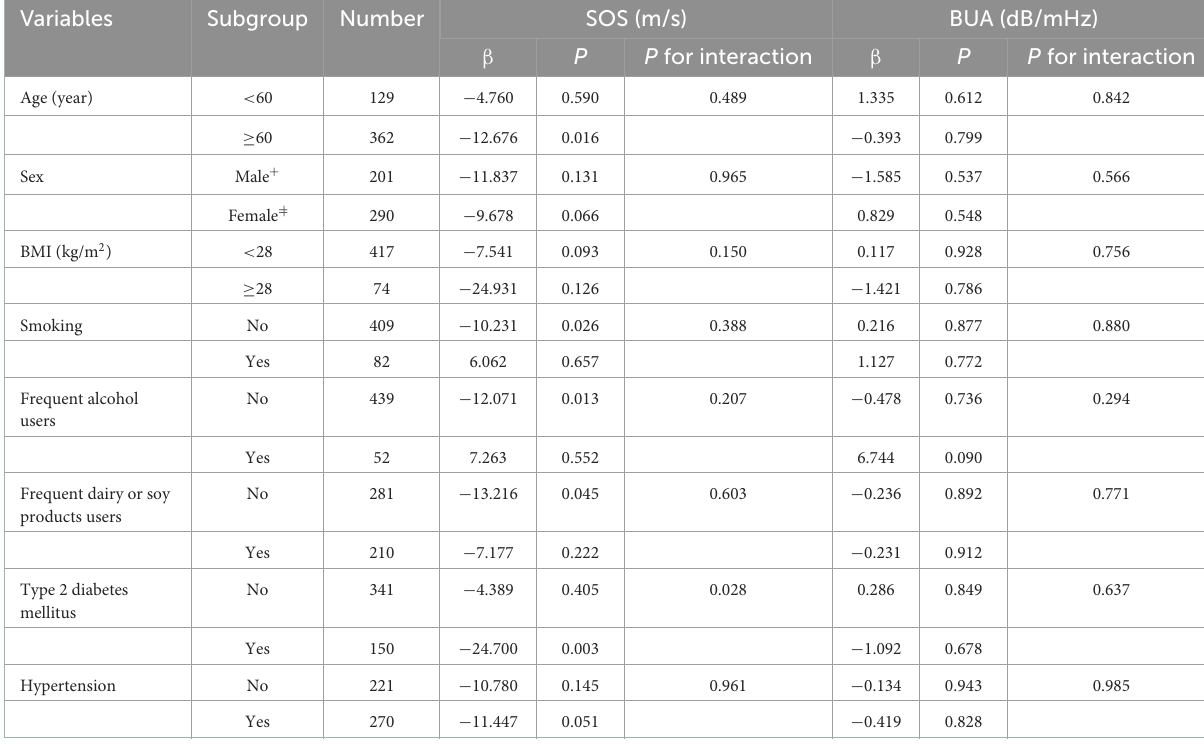
TABLE 3 Fluorescent oxidation products (FlOPs, Per increase of logarithmic interquartile range) and quantitative ultrasound (QUS) parameters: multivariable linear regression analysis stratified by age, sex, BMI, smoking, frequent alcohol users, frequent dairy or soy products users, type 2 diabetes mellitus, and hypertension G